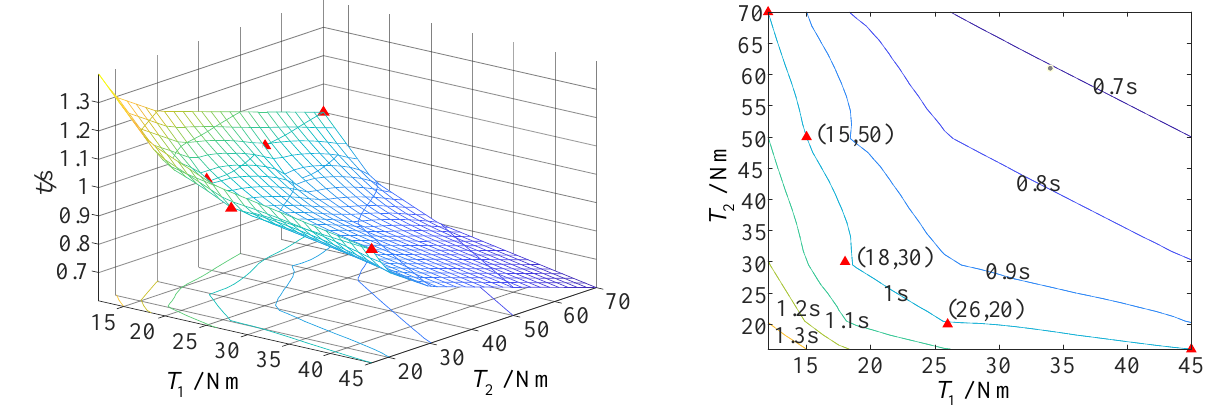
0.44s 0.42s Figure 15. The curve of driving torque and deployment time of folding wing at an airspeed of 40 m/s